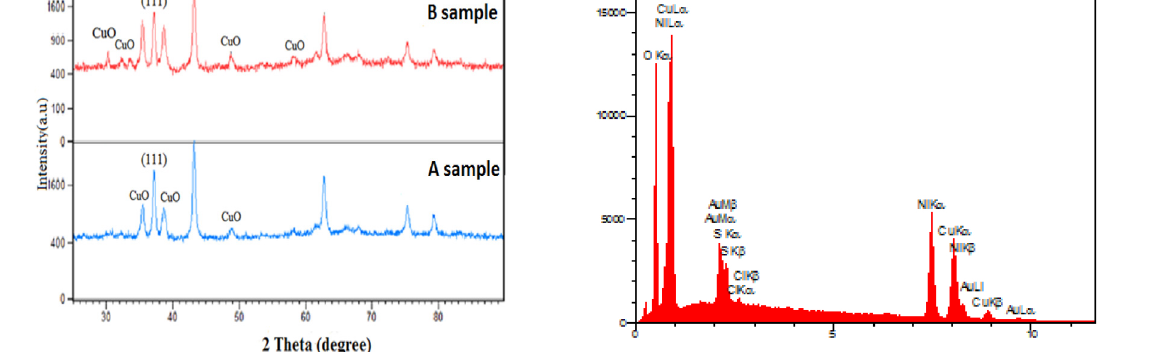
Fig. 1. XRD patterns of CuO-NiO Nanocomposites after calcinations